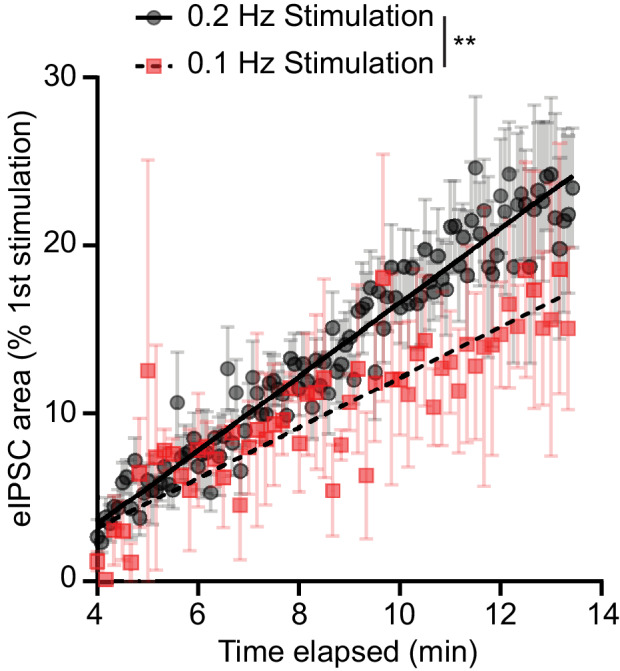
Rate of unblock following PTX application is use-dependent.Quantification of eIPSC recovery following KCl treatment with PTX. The eIPSC response recovers more slowly with lower stimulation frequency indicating that unblock of GABAARs from PTX is at least partially use-dependent. Data were fitted with linear regressions (0.2 Hz stimulation, solid line, n = 6; 0.1 Hz stimulation, dashed line, n = 4) which were significantly different from each other (Sum-of-squares F test F(1,873) = 18.57, p<0.0001). Graph is mean ± SEM. ** indicates p<0.01.Figure 5—figure supplement 1—source data 1.Source data for Figure 5—figure supplement 1.